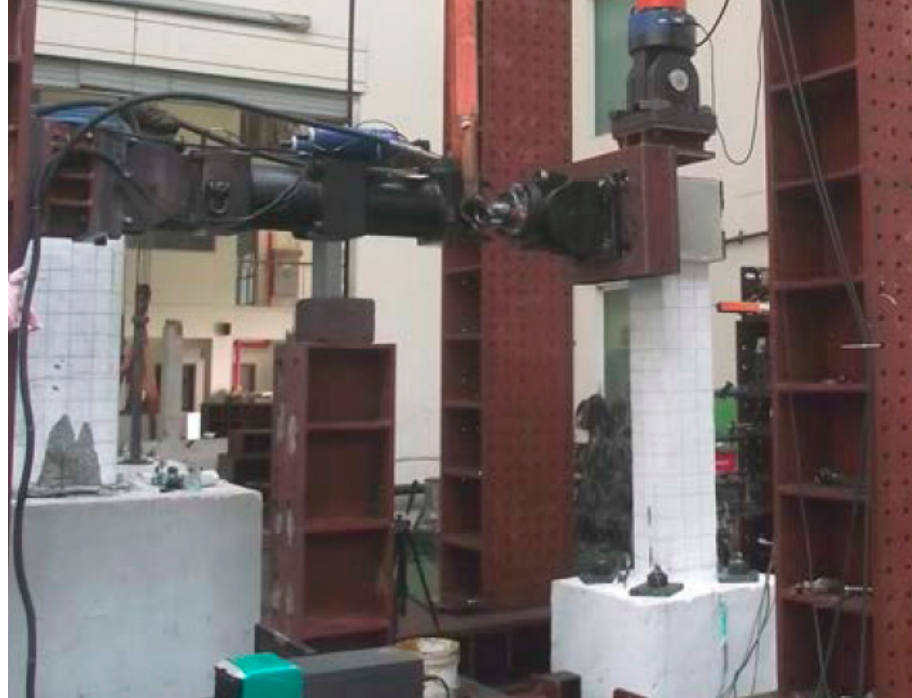
Figure 5. Setup for cyclic loading test.